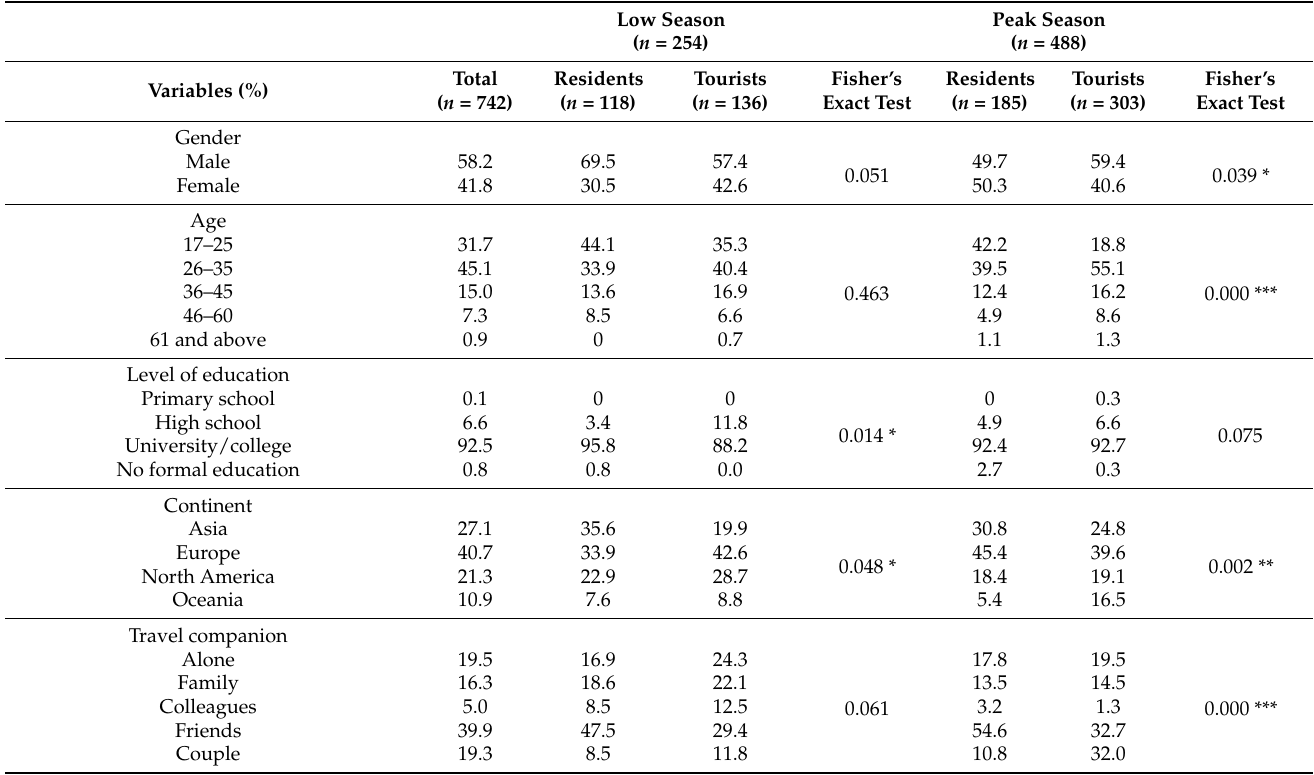
Table 1. Comparison of sociodemographic and travel characteristics between foreign resident and tourist visitors to Mt. Takao during the low and peak